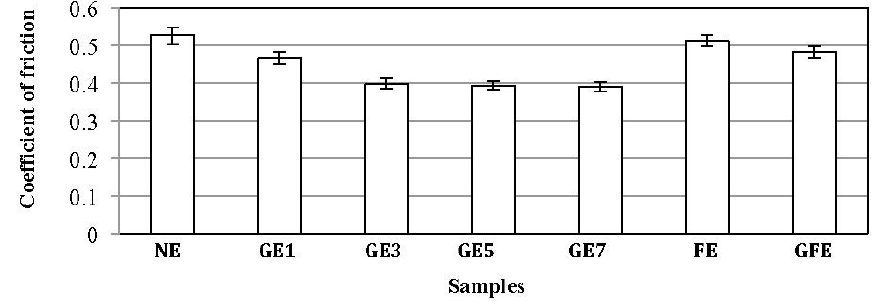
Figure 3. Coefficient of friction of the fillers/epoxy composites after a 7.5-km sliding